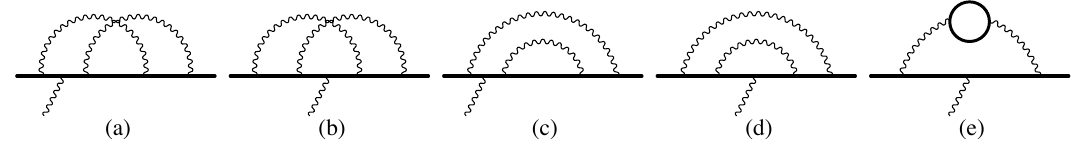
Figure 2. Fourth-order vertex diagrams. There are seven diagrams in total. The time-reversal diagrams of ( a , c ) are not shown. The solid and wavy lines represent electron and photon propagators, respectively. Reprinted from [12].